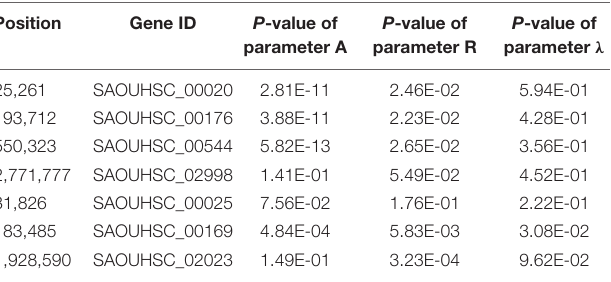
TABLE 3 | Growth parameters t -test of two genotypes in 6 µ